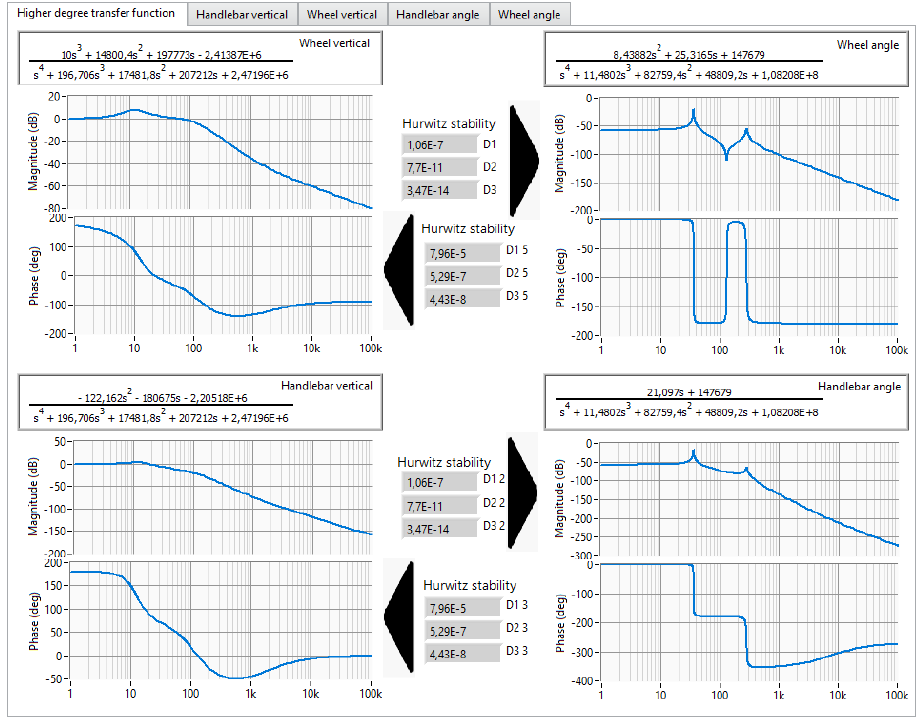
Figure 3. View of the steering frequency analysis program window.